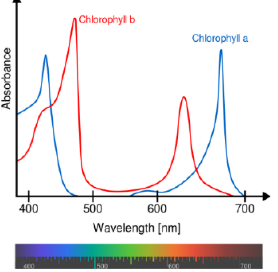
Figure 1. Absorbance spectra for chlorophyll pigments